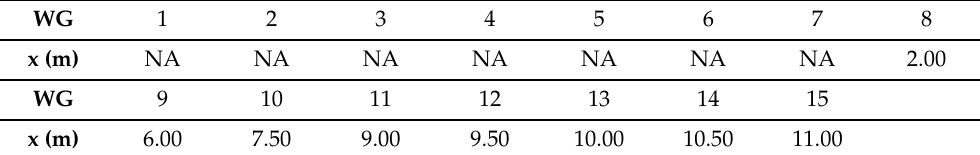
Table 4. Position of wave gauges in the physical